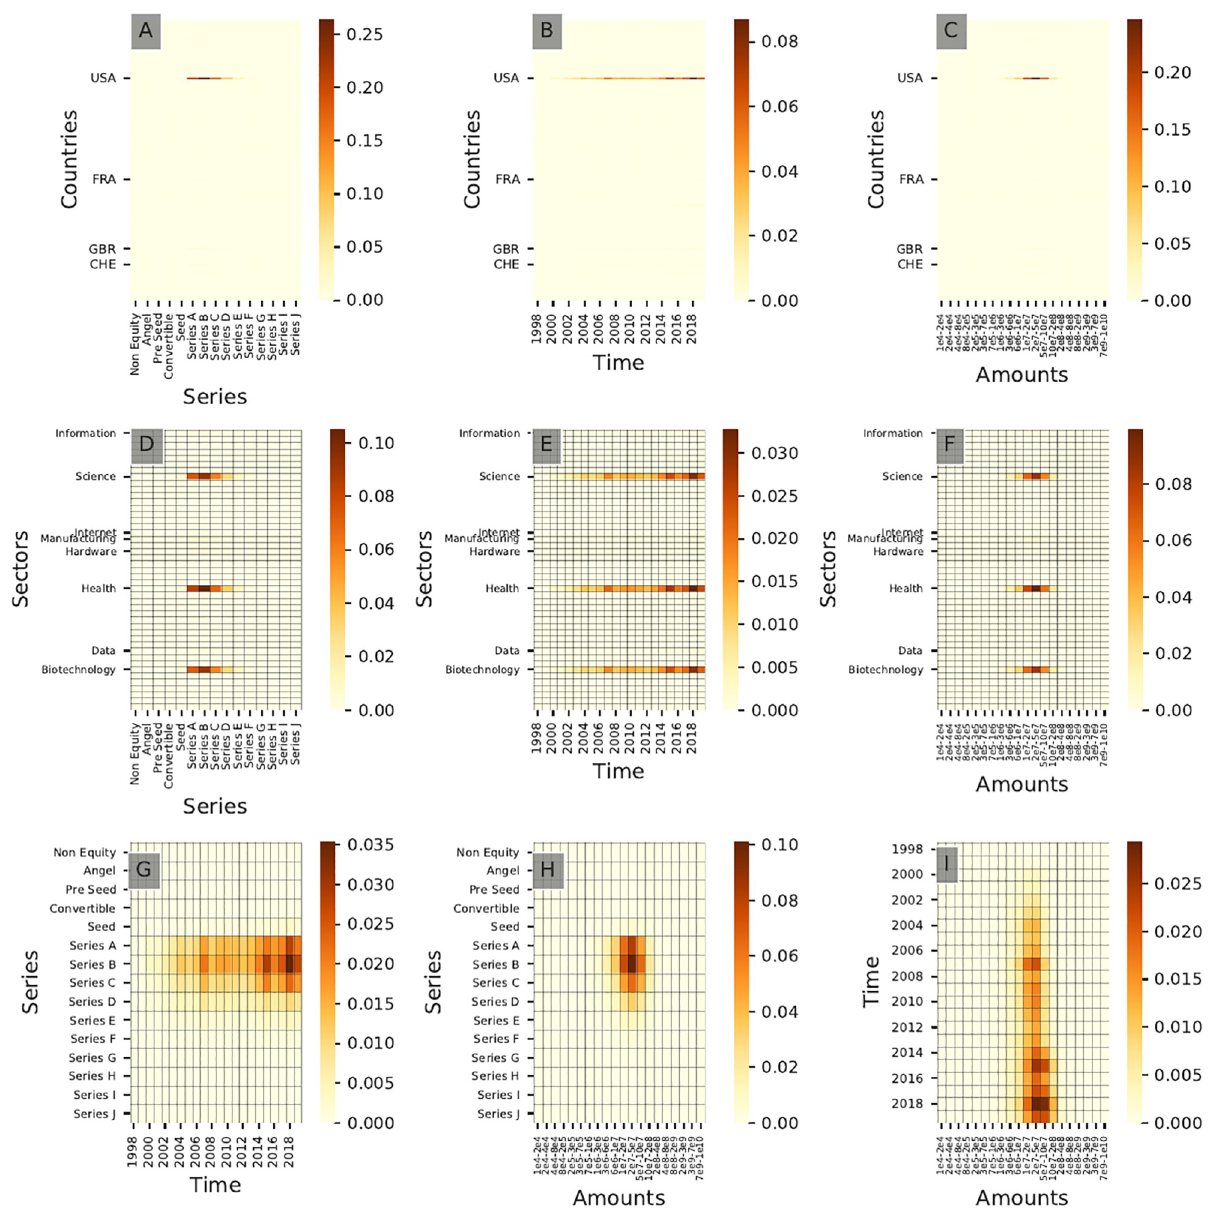
Fig 14. Cross-interaction heatmaps for community A7. These distributions correspond to Health Care